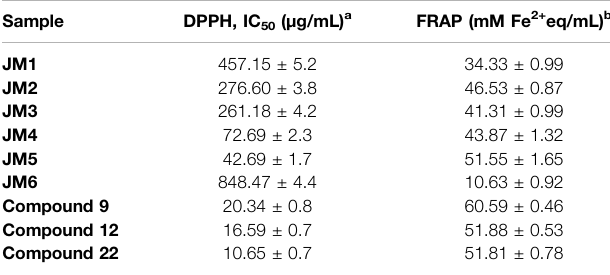
TABLE 2 | Antiradical activity against DPPH radical (IC 50 , µg/mL) of JM1 – JM6 extracts and compounds ( 9 , 12 , and 22 ), FRAP values (mM Fe 2+ per